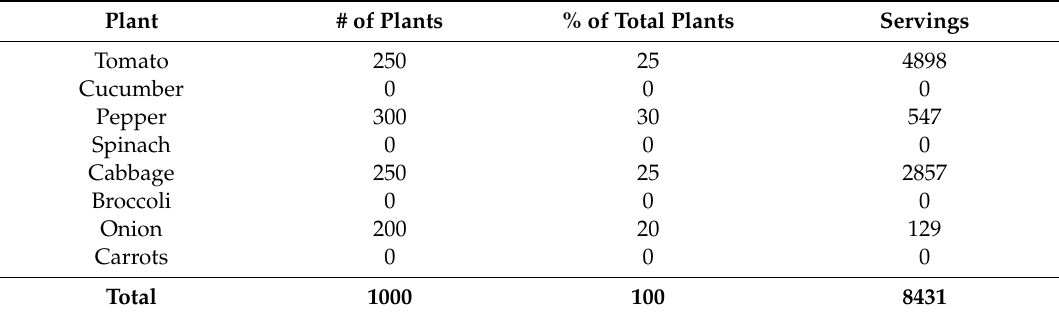
Table 3. Optimal plant quantities and varieties.